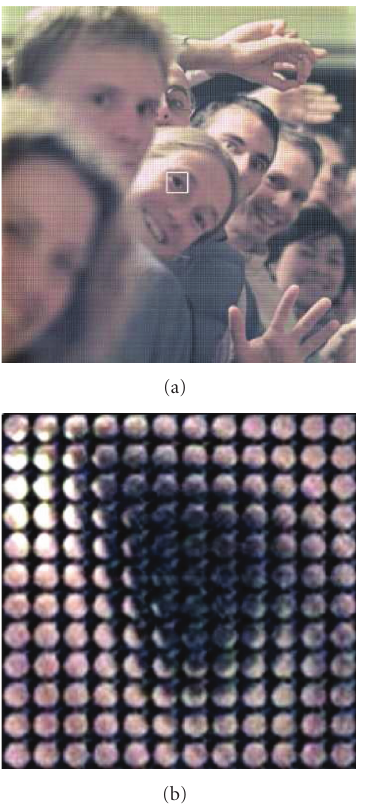
Figure 2: (a) Lightfield captured by a plenoptic camera. (b) Detail from the white square in the left image.